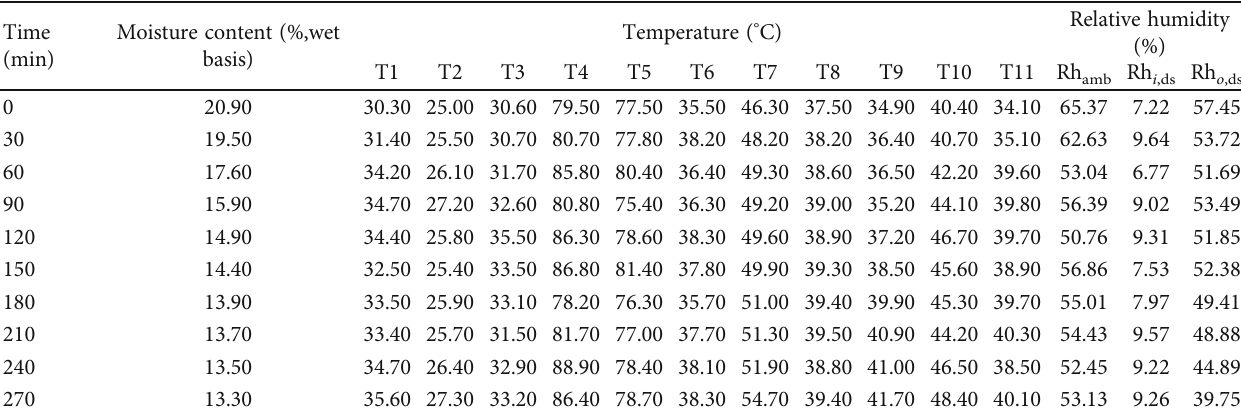
Table 3: Data from the drying experiment, used for the performance analysis of the